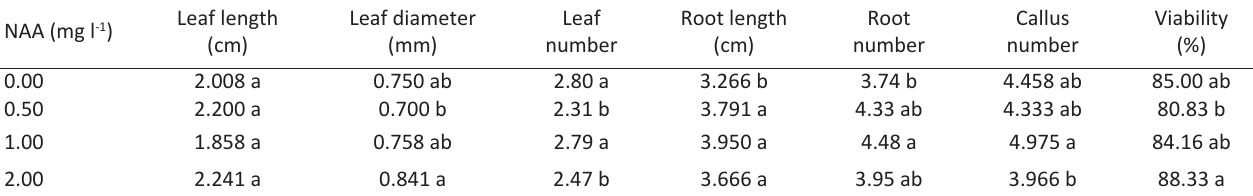
Table 3 ­ Mean comparison of the effect of different concentrations of NAA on measured characters of Fritillaria imperialis L.